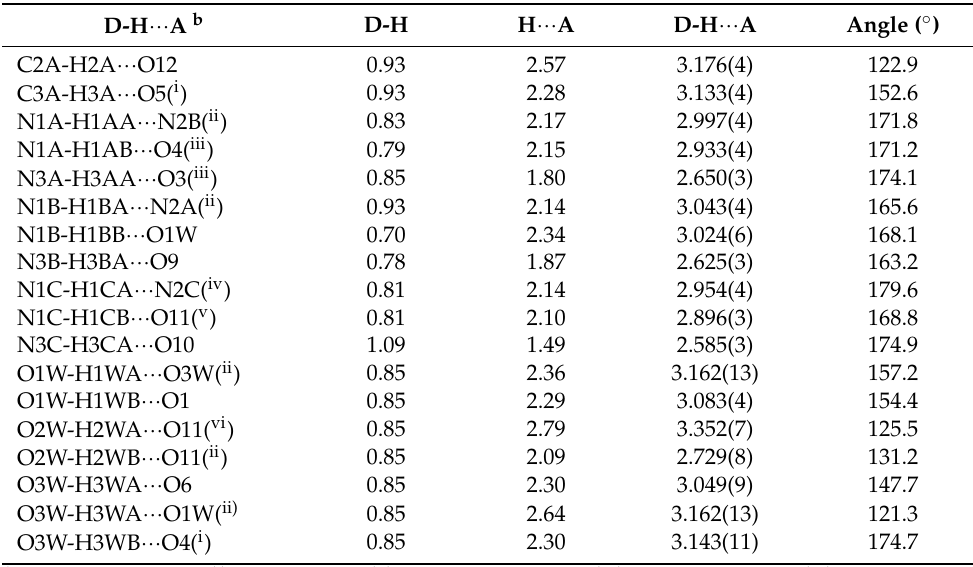
Figure 2. Partial supramolecular structure of Compound 1 based on hydrogen bonds (blue dashed line) among the [2-ampymH] + cations and decavanadate anions. The structure is colored by symmetric equivalence. C cations (in red) form hydrogen bonds with each other, while A and B cations (in green and blue, respectively) interact between them. Table 3. Distances (Å) and angles ( ◦ ) of the hydrogen bonds of Compound 1